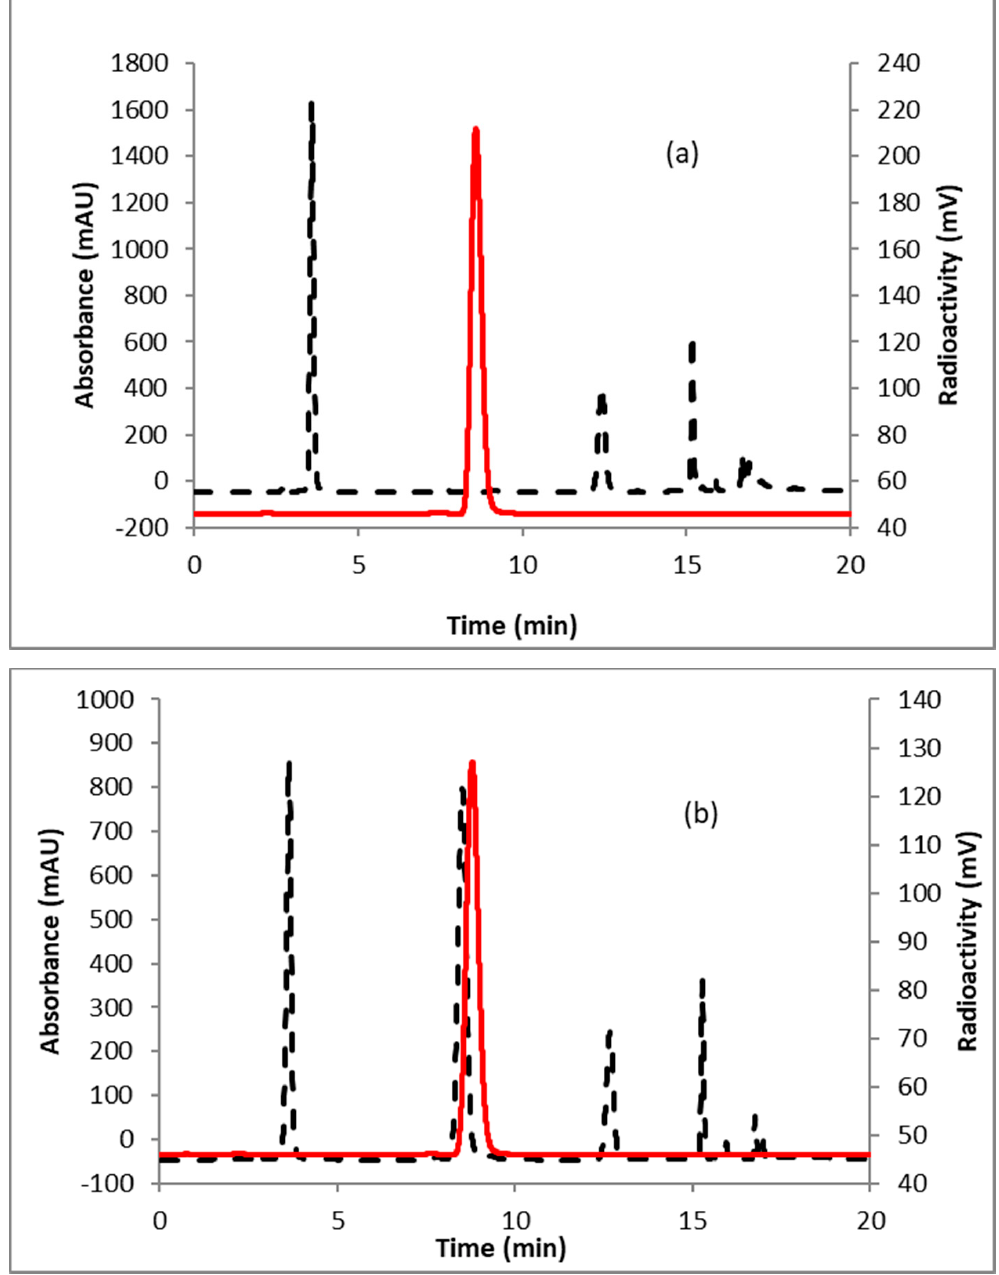
Figure 2. HPLC analysis (method A) of crude reaction mixture of ( a ) [ 18 F]FFNP; ( b ) [ 18 F]FFNP, co-injected with the non-radioactive standard. Solid line, in-line radio detector; dotted line, UV detector at 254 nm.